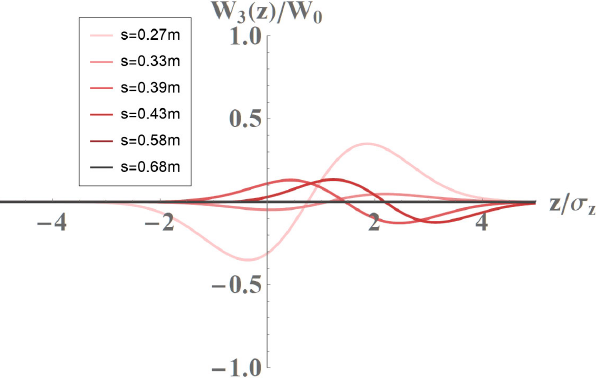
FIG. 15. Evolution of W 3 ð z Þ inside magnet B2 in beamline C